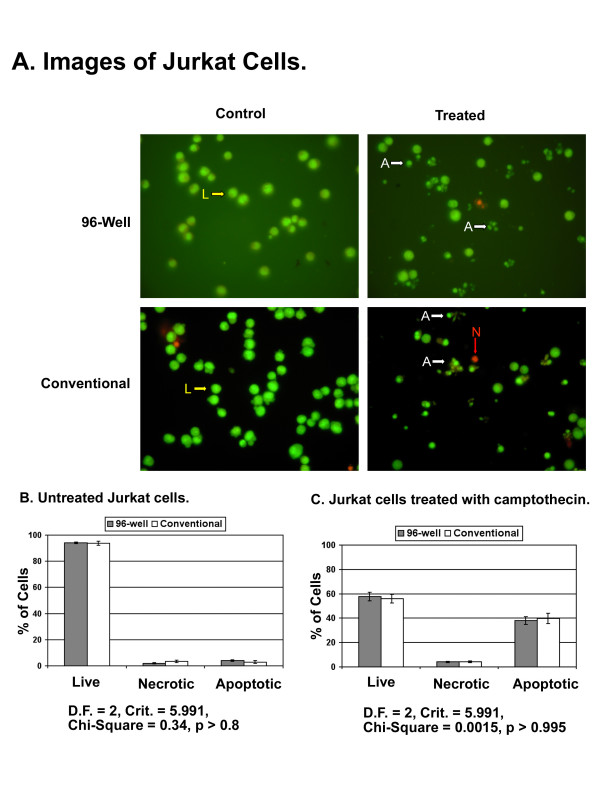
Comparison of a 96-well-based and the conventional EB/AO method for Jurkat suspension cells. Jurkat cells were treated with 6 μM camptothecin for induction of apoptosis. (A) -Images of the cells. Yellow arrows next to "L" point to live cells; white arrows next to "A" indicate apoptotic cells; and red arrows next to "N" indicate necrotic cells. (B) Quantification of untreated live, necrotic, and apoptotic cells. (C) Quantification of live, necrotic, and apoptotic cells treated with camptothecin. p-values from chi-square tests were marked on the bottom of each graph.